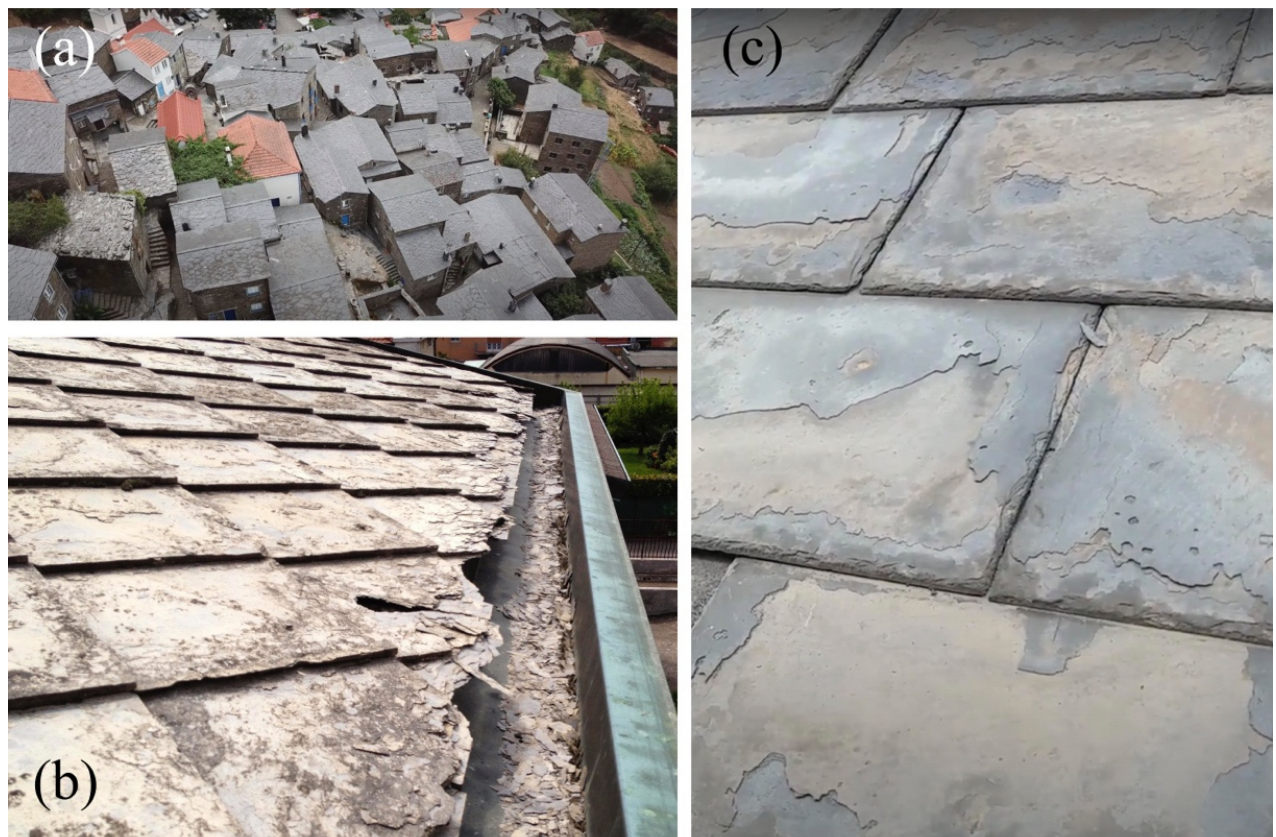
Figure 2. ( a , c ) Examples of slates used for roofing applications and associated damage due to snow accumulation; ( b ) damage due to frost action photo credits by Marco Argiolas .